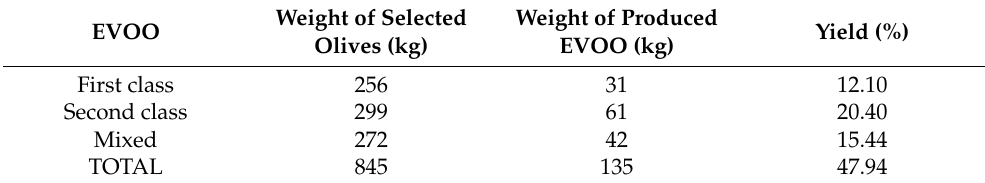
Table 2. Weight of processed olives and produced oil and relative yield. The first class EVOO is obtained from GOOD selected olives, the second class EVOO from BAD selected olives and mixed EVOO from unprocessed mixed olives.